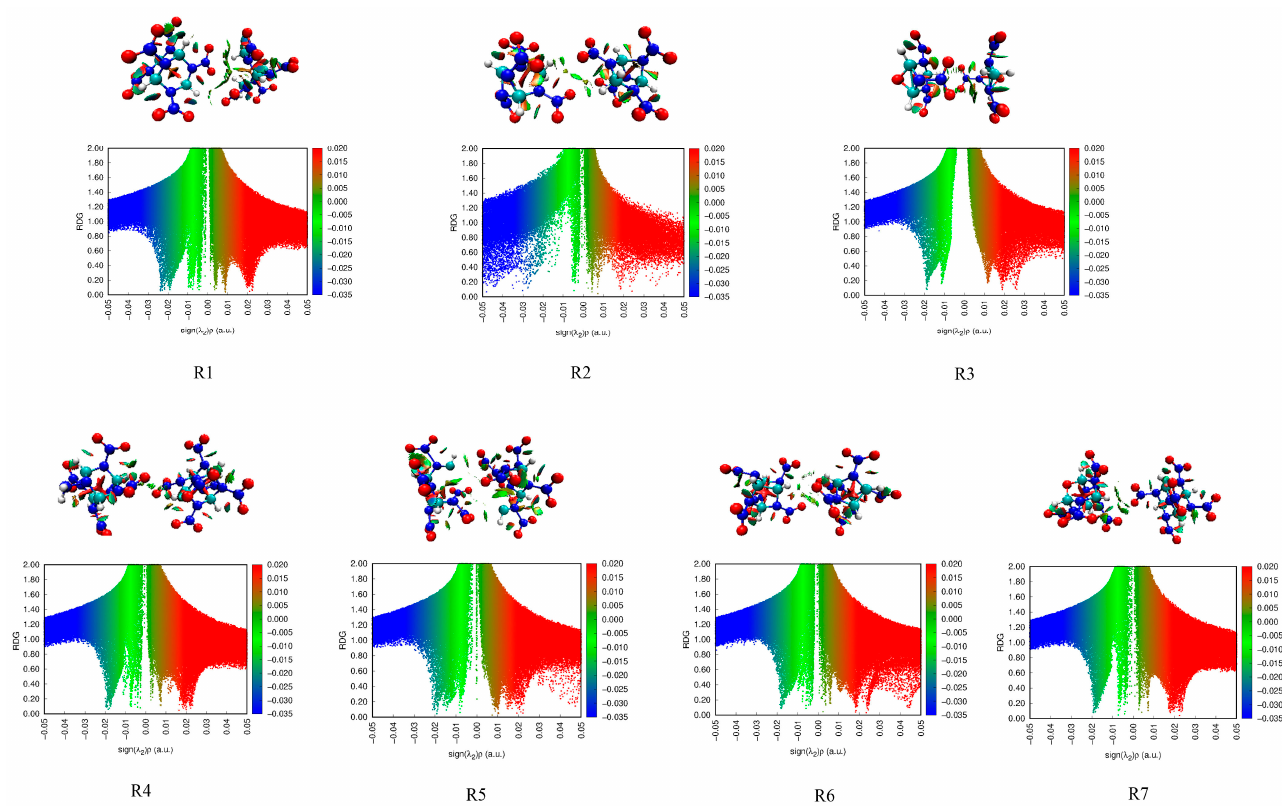
Figure 5. Scatter diagram and isosurface graph of RDG for configurations of seven bimolecular assembles. In Figure 5, the two peaks of sign( λ 2 ) ρ in the range of − 0.03~0 a.u. indicate two types of interactions in the molecules: weak hydrogen bonding ( − 0.03~ − 0.01 a.u.) and van der Waals interaction ( − 0.01~0 a.u.). In addition, hydrogen bonding is the main intermolecular force. The values of sign( λ 2 ) ρ are over 0, so there is a steric effect and the red area is shown in the bimolecular assembles. For R1, R2, and R3, the dots on the graph are denser than those of other compounds, indicating that there are stronger weak hydrogen bonding and van der Waals interactions. This is the same as previous conclusions that R1, R2, and R3 are more stable than R4 − R7. Within the RDG color-filled maps, there are green areas in the oxygen atoms of the nitro groups and the hydrogen atoms, showing weak hydrogen bonds and van der Waals interactions in the bimolecular assembles. In R2, R3, R6, and R7, the light green regions appear between the oxygen atoms of the nitro groups in the bimolecular assembles, indicating the existence of O ··· O